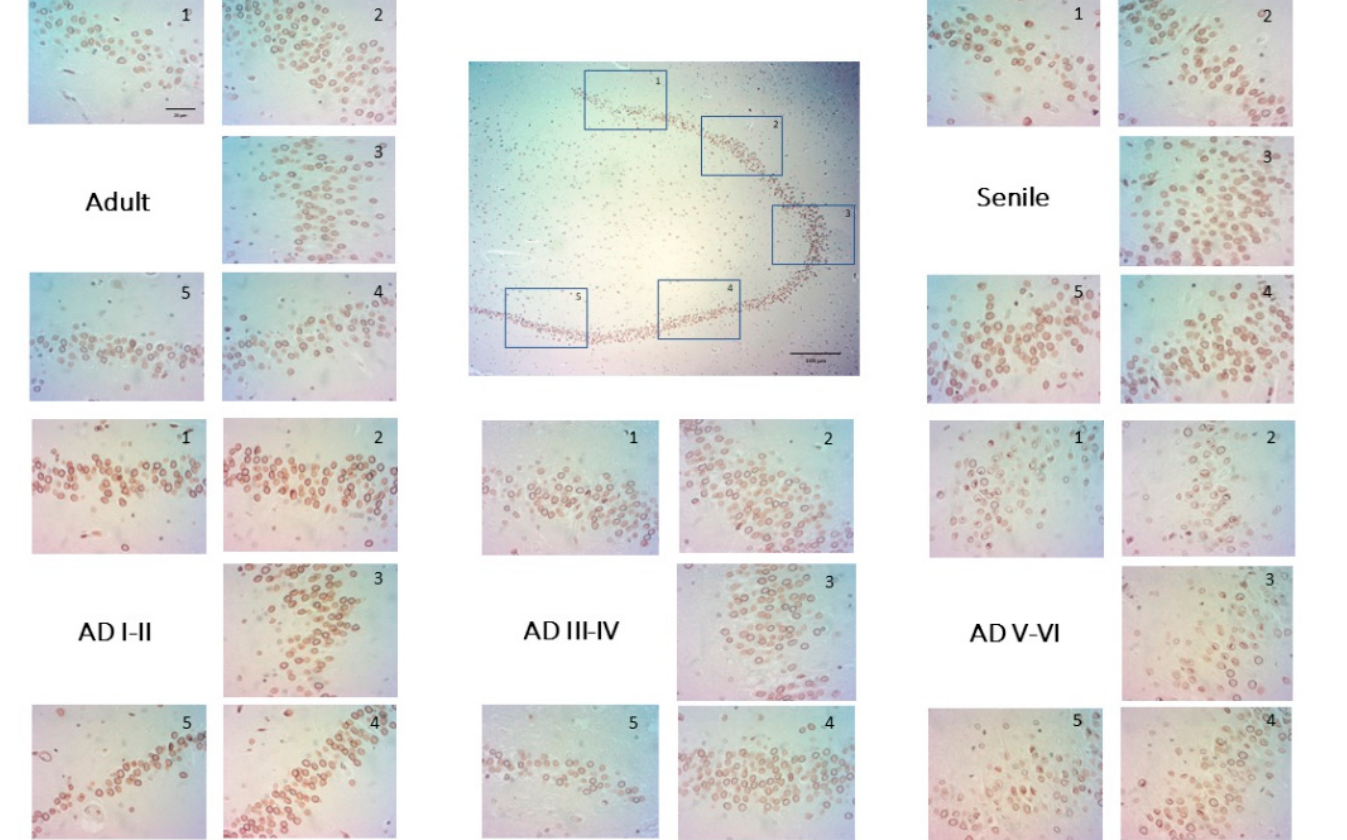
Figure 1. Changes in pyramidal neurons of layer II of the entorhinal cortex. Perinuclear and nucle- oplasmic (arrow) Lamin B2 ( A – E ). Lamin A absence in adult and senile stages ( F , G ) and presence in AD I–IV stages ( H , I ) and absence in AD V-VI stages ( J ). Nuclear Tau, AT100 ( K – M ), AT8 ( Q ) cytoplasmic and extracellular AT100 and AT8 ( N , O , R – T ). Absence of nuclear Tau AT8 ( P ). Scale bar: 20 µm .